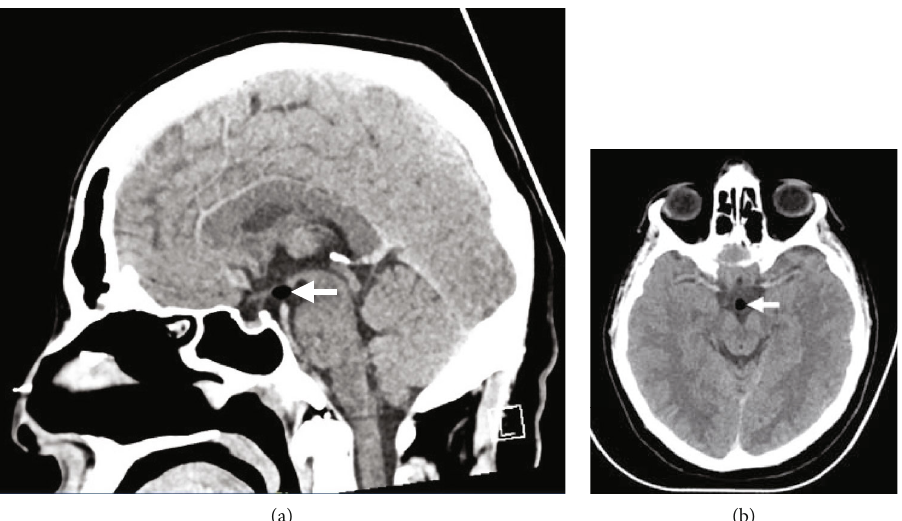
Figure 5: (a) Sagittal brain CT. (b) Axial brain CT. (a) and (b) The images demonstrate a small hypodense lesion, measuring 5 × 7mm , consistent with hypothalamic lipoma.